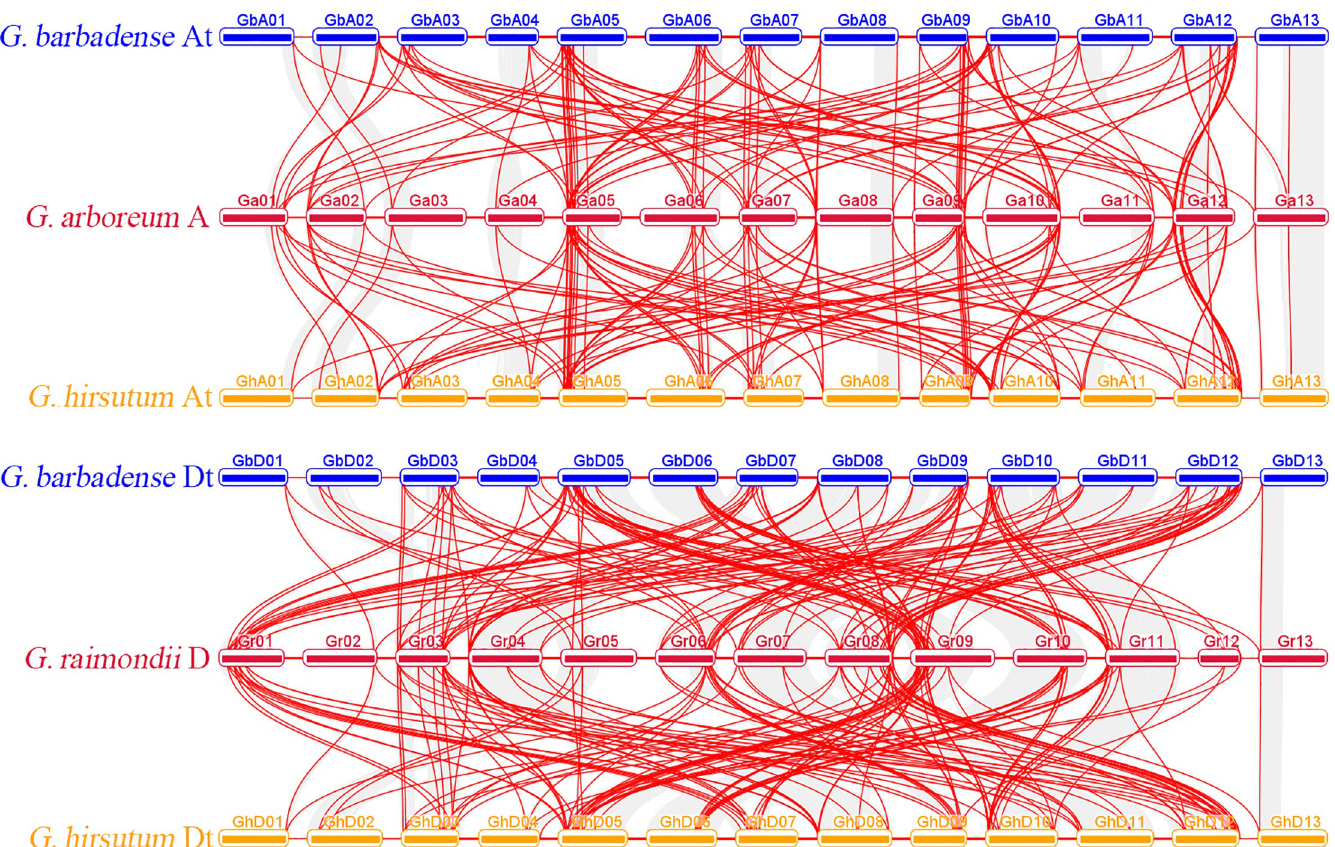
Fig 2. The sub-genome distribution and synteny analysis of cotton Dof genes. The red lines indicate duplicated Dof pairs, the gray lines indicate collinear blocks.